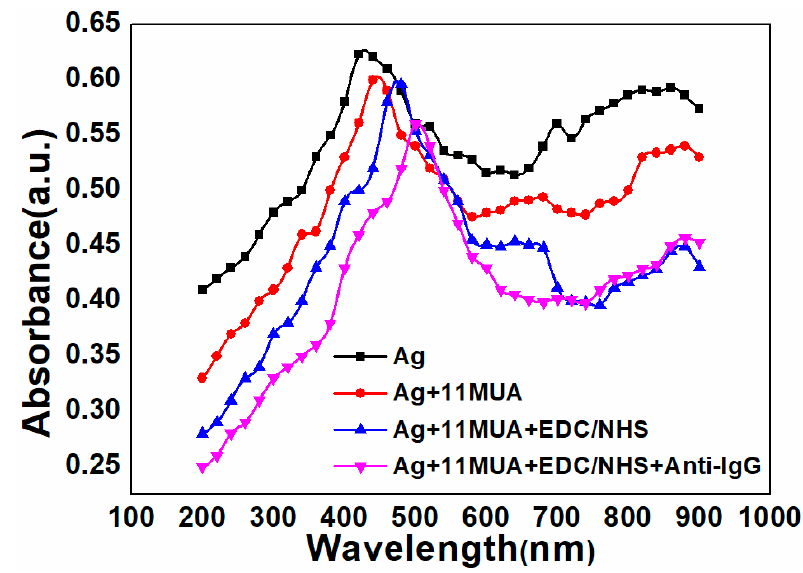
Figure 3. UV-Vis spectroscopic optical absorbance spectra of the sensor surface before and after immobilization of